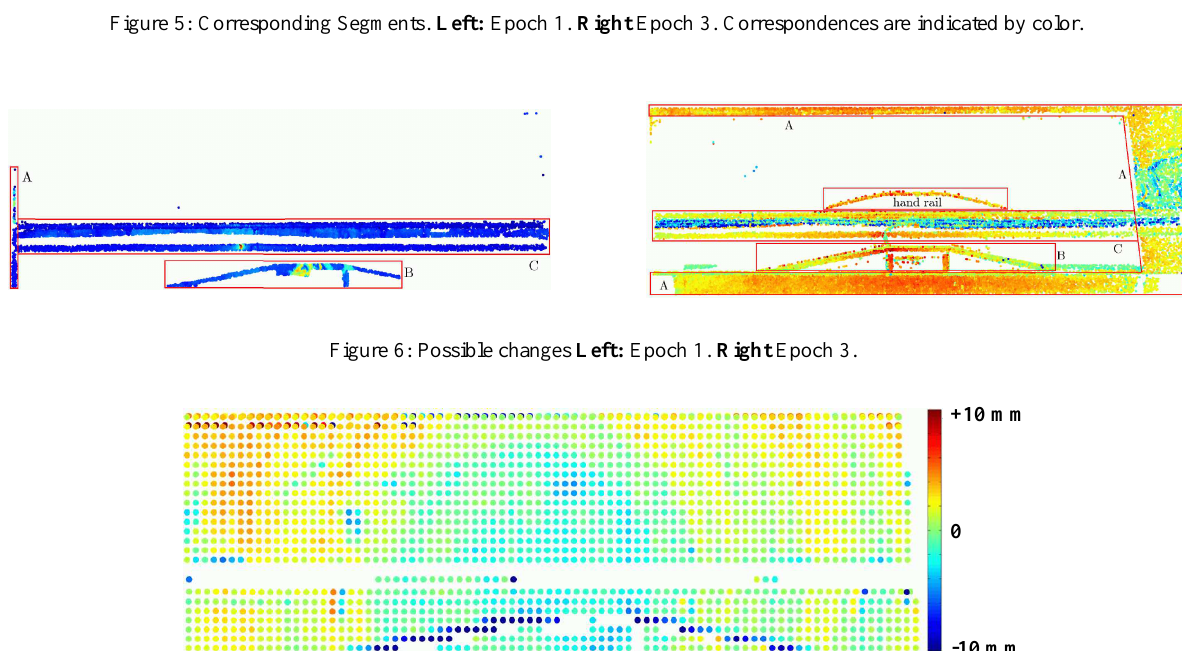
Figure 5: Corresponding Segments. Left: Epoch 1. Right Epoch 3. Correspondences are indicated by color.